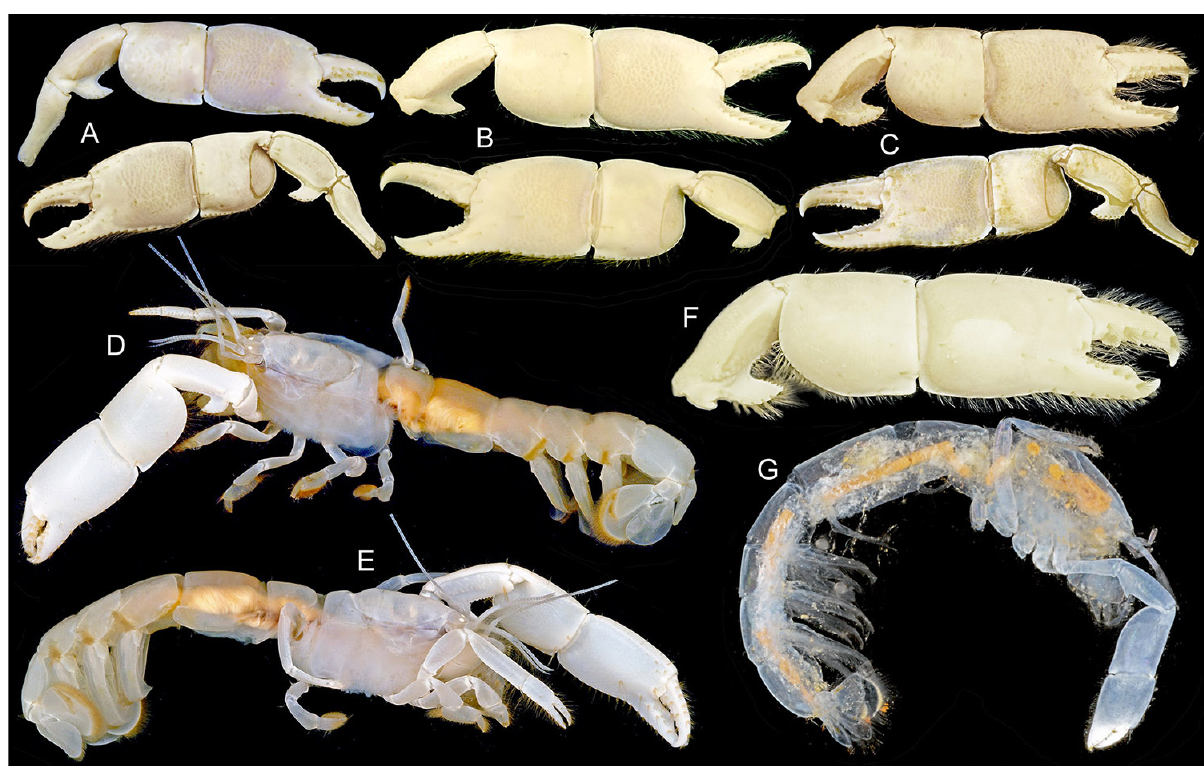
Figure 6. Gilvossius setimanus s.s. ( A–C ), Gilvossius howellorum n. sp. ( D–F ), Gilvossius fredericqae n. sp. ( G ). A , male, preserved major cheliped, external above, internal below, prpdl 16.1 mm (USNM 9238), Massachusetts; B , female, preserved major cheliped, external above, internal below, prpdl 16.1 mm (USNM 9238), Massachusetts; C , male, preserved major cheliped, external above, internal below, prpdl 18.6 mm, pocl 15.5 mm (USNM 20869), Rhode Island; D, E , male holotype, pre-preservation specimen in lateral